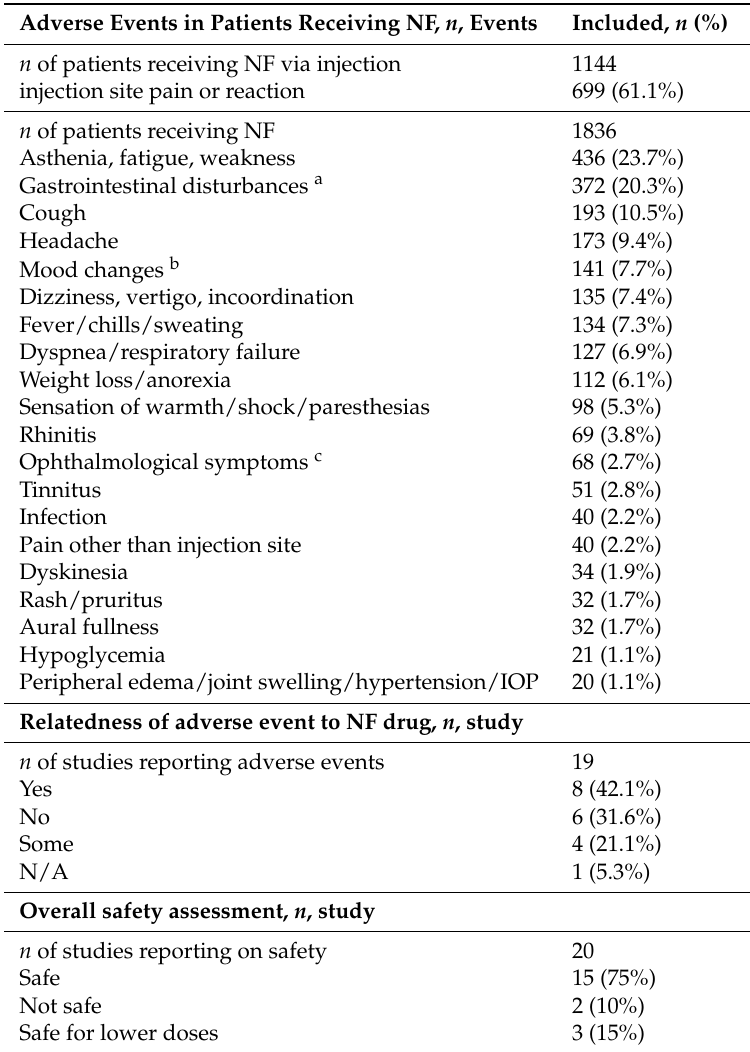
Table 5. Summary of safety assessments of neurotrophic factor (NF) based treatment in selected studies. Adverse Events in Patients Receiving NF, n , Events Included, n